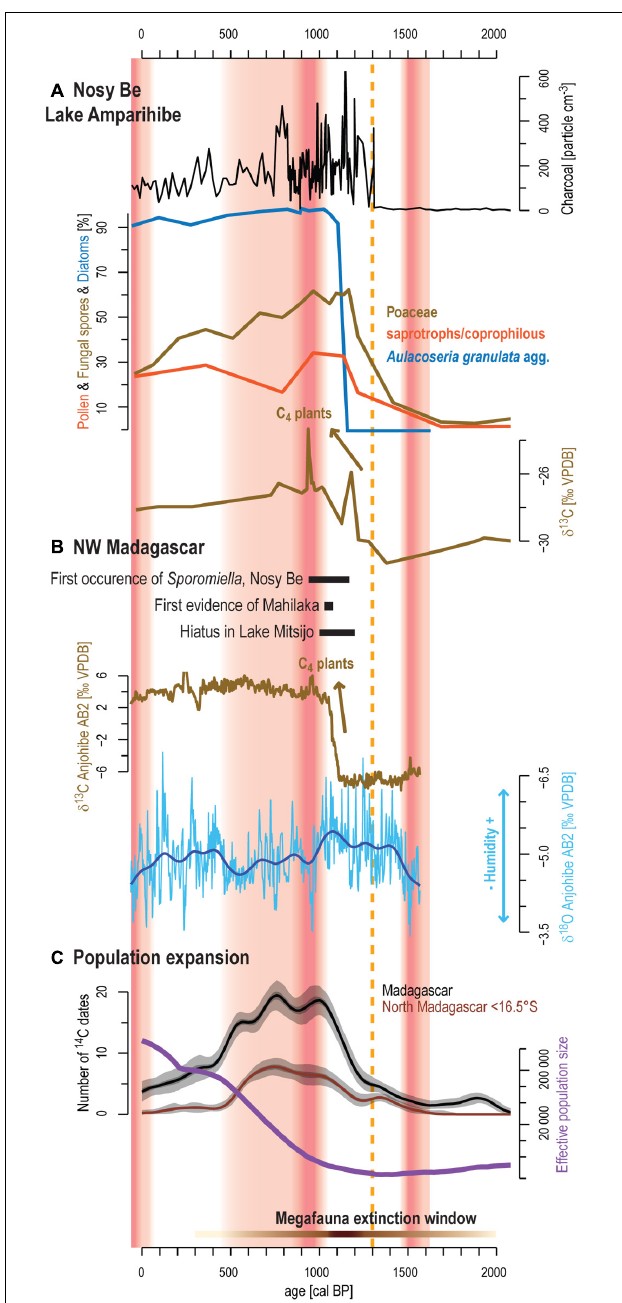
FIGURE 8 | Synthesis of environmental changes in northwestern Madagascar during the past 2000 years. (A) main results from sediment sequence AMP16 showing macro-charcoal concentration, percentages of Poaceae, saprotrophs/coprophilous fungal spores and diatom from Aulacoseria granulata agg. and the δ 13 C signal. (B) Evidence of initial human occupation on Nosy Be (Burney et al., 2003) and Mahilaka (Crowther et al., 2016). Hiatus in Lake Mitsijo interpreted as a dry period (Matsumoto and Burney, 1994) and δ 13 C and δ 18 O speleothem profiles from Anjohibe cave showing C 3 /C 4 vegetation and dynamic and precipitation changes (Scroxton et al., 2017). (C) Black curve and brown curve represent the number of 14 C dated archeological samples obtained from Douglass et al. (2019) for the whole (Continued)